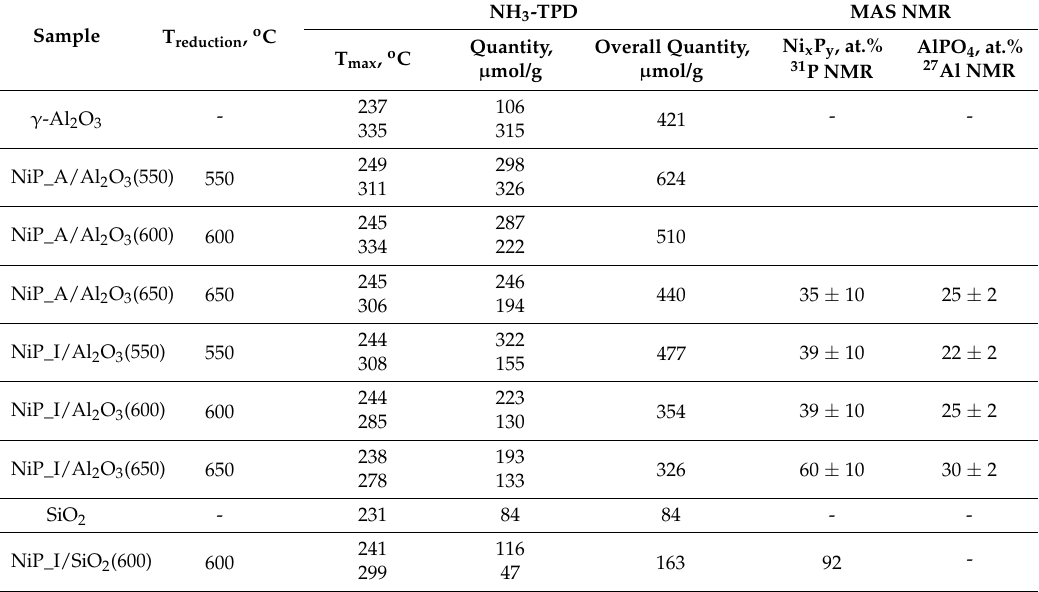
Figure 5. NH 3 -TPD profiles of Ni x P y /Al 2 O 3 catalysts prepared from different precursors: ( a ) NiP_A/Al 2 O 3 and ( b ) NiP_I/Al 2 O 3 and γ -Al 2 O 3 sample. Table 2. Summary data of NH 3 -TPD and MAS NMR methods for NiP_A/Al 2 O 3 and NiP_I/Al 2 O 3 catalysts, γ -Al 2 O 3 support as well as SiO 2 and NiP_I/SiO 2 catalyst.